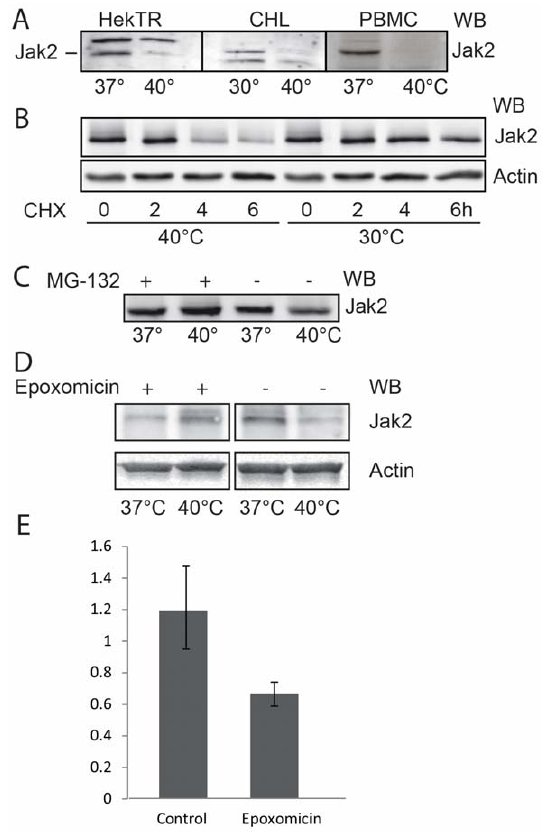
Figure 1. Effect of stressors on Jak2 protein levels in various cell types. ( A ) Hek293-TR, Chinese hamster lung and PBM cells were incubated for 3 h, as indicated. The cells were lysed in 1% Triton X-100 and equal aliquots of the lysates were analyzed by western blotting (WB) for endogenous Jak2, using anti-Jak2 antibody. The antibody recognized a-specific bands in lysates of HekTR (above Jak2) and CHL (below Jak2). ( B ) In the presence of 20 m g/ml cycloheximide (CHX) Chinese hamster cells were transiently transfected with Jak2 and incubated at either 37 or 40 u C. The cells were lysed in 1% SDS and equal aliquots were analyzed (WB) using anti-Jak2 and anti-actin antibodies. ( C ) Equal amounts of isolated PBMCs were incubated with or without 20 m M MG-132 at 37 or 40 u C for 4 h. The cells were lysed in 1% SDS and equal amounts were analyzed (WB) using anti-Jak2 antibody. ( D ) Effect of Epoxomicin on Jak2 protein levels in PBMCs. Equal amounts of isolated PBMCs were incubated with or without10 m M Epoxomicin at 37 or 40 u C for 4 h. The cells were lysed in 1% SDS and equal amounts were analyzed (WB) using anti-Jak2 antibody. The data in (A, B, C, D) are representative of three independent experiments. ( E ) Quantification of (D). The ratio of Jak2 to actin signals (western blot) were calculated. The data represent the mean of three independent experiments 6